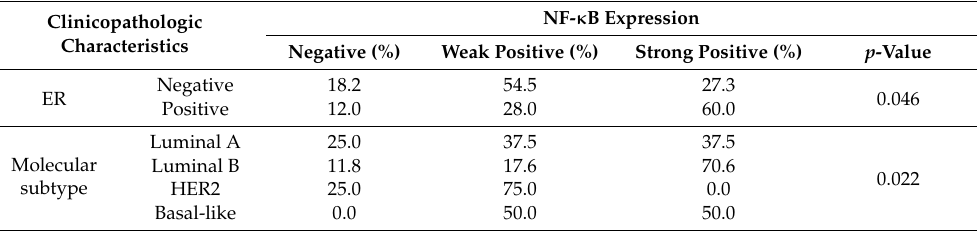
Table 5. Association between nuclear factor-kappaB (NF- κ B) and clinicopathologic characteristics in breast cancer.